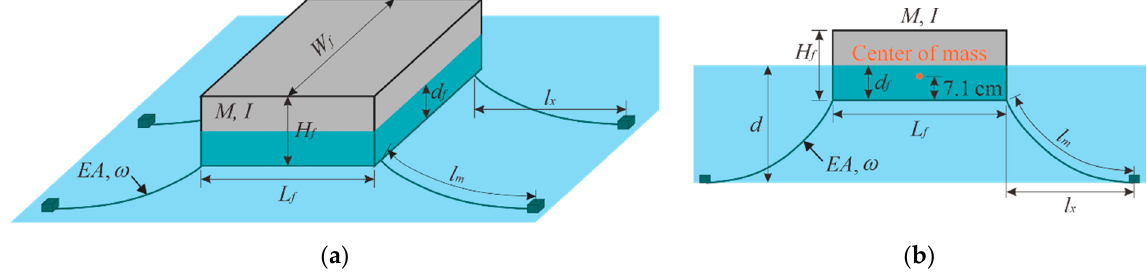
Figure 4. Setup of the cuboid floating pontoon and its mooring system: ( a ) Physical model; ( b ) Numerical model. Table 1. Parameters of the cuboid floating pontoon and its mooring system.